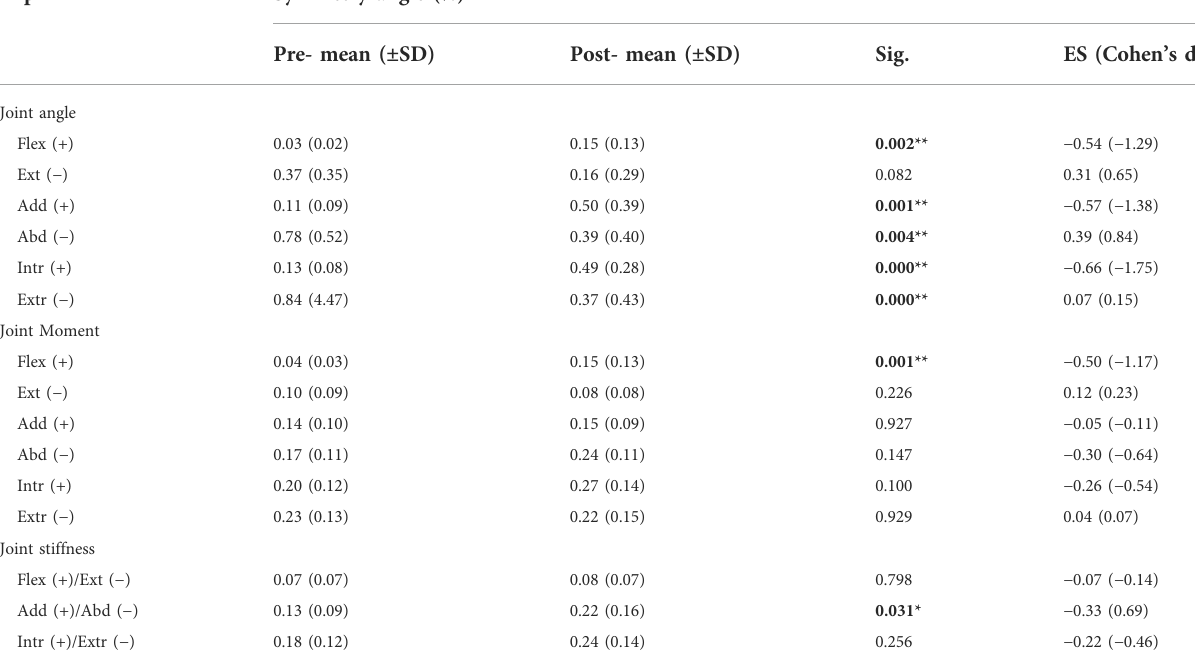
TABLE 4 Changes of hip joint angle, joint moment, range of motion and joint stiffness symmetry before and after